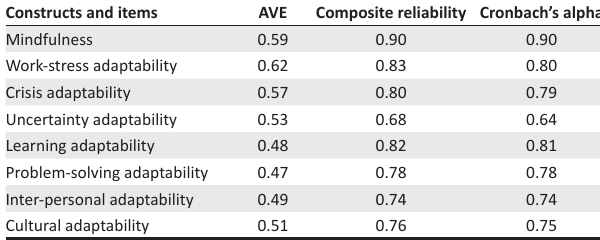
TABLE 2: Construct validity and reliability for re-estimated measurement